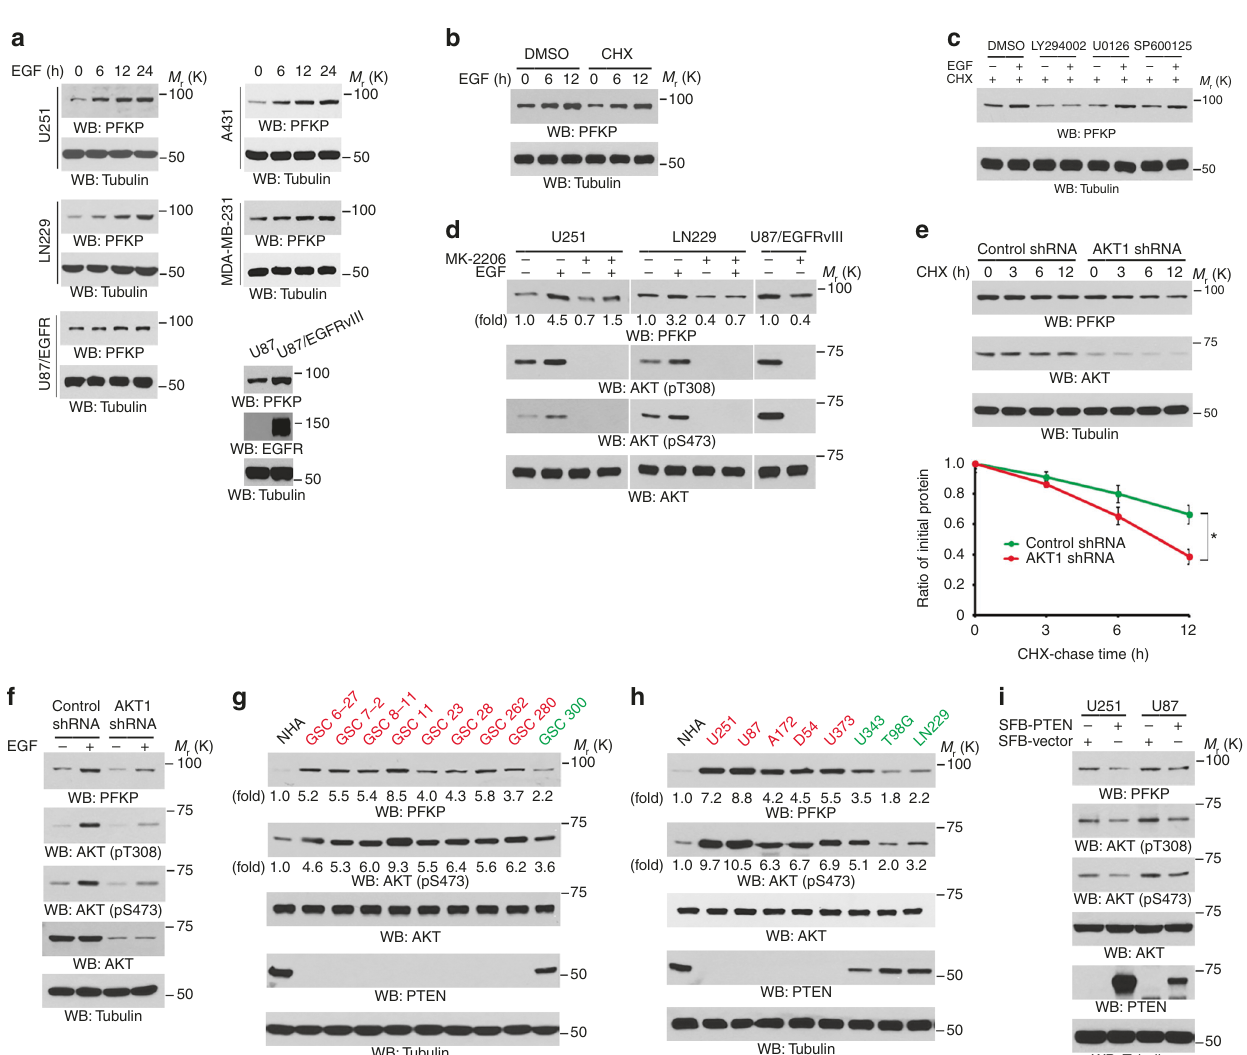
Fig. 2 AKT activation resulted from PTEN loss and EGFR-dependent PI3K activation induces PFKP upregulation. Immunoblotting analyses were performed with the indicated antibodies. a The indicated tumor cells were serum-starved for 12 h and then stimulated with or without EGF (100 ng ml − 1 ) for the indicated periods of time. b Serum-starved U251 cells were stimulated with or without EGF (100 ng ml − 1 ) for the indicated periods of time in the presence of DMSO or CHX (100 μ g ml − 1 ). c Serum-starved U251 cells were pretreated with CHX (100 μ g ml − 1 ) for 1 h and then stimulated with EGF (100 ng ml − 1 )